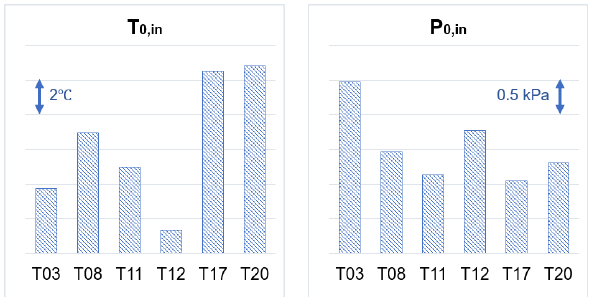
Figure 4. Average dimensional inlet total temperature and total pressure for the six cases experimen- tally tested by Ansaldo Energia Switzerland.